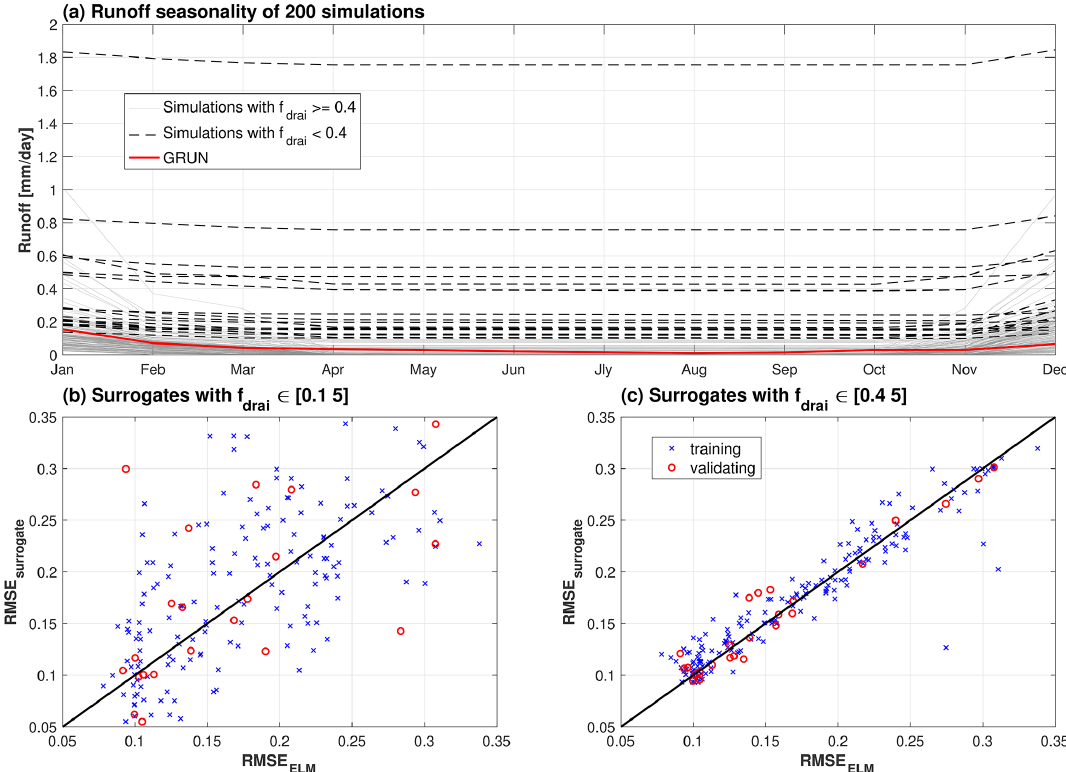
Figure 1. Validation of surrogate performance for an example grid cell from an arid region. Panel (a) shows runoff seasonality from all 200 simulations with samples from parameter priors. Panel (b) shows the validation of the surrogate model trained with original ranges of f drai given in Table 1 in the main text. Panel (c) shows the validation of the surrogate model trained with constrained f drai .